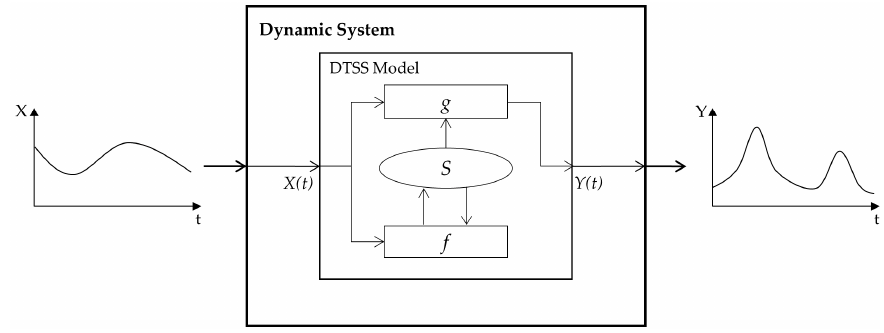
Figure 1. An example of a dynamic system model: Discrete time system specification (DTSS) model.